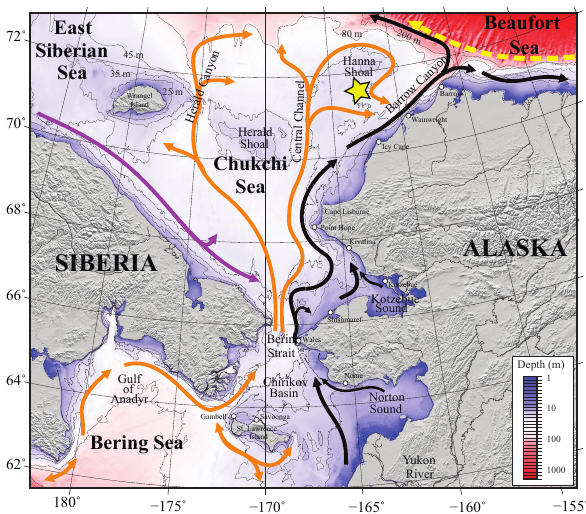
Figure 2. Bathymetry of the Chukchi, northern Bering, East Siberian and eastern Beaufort seas. The Chukchi Ecosystem Ob- servatory (CEO) near Hanna Shoal is marked with a yellow star. General circulation patterns are shown with arrows: black – Alaskan Coastal Water and Alaskan Coastal Current, dividing into the Shelf- break Jet (right) and Chukchi Slope Current (left, Corlett and Pickart, 2017); orange – Anadyr, Bering Sea, and Chukchi Sea Water; purple – Siberian Coastal Current; yellow – Beaufort Gyre boundary current. “Water” designations were used for locations where persistent currents have not been identified and named